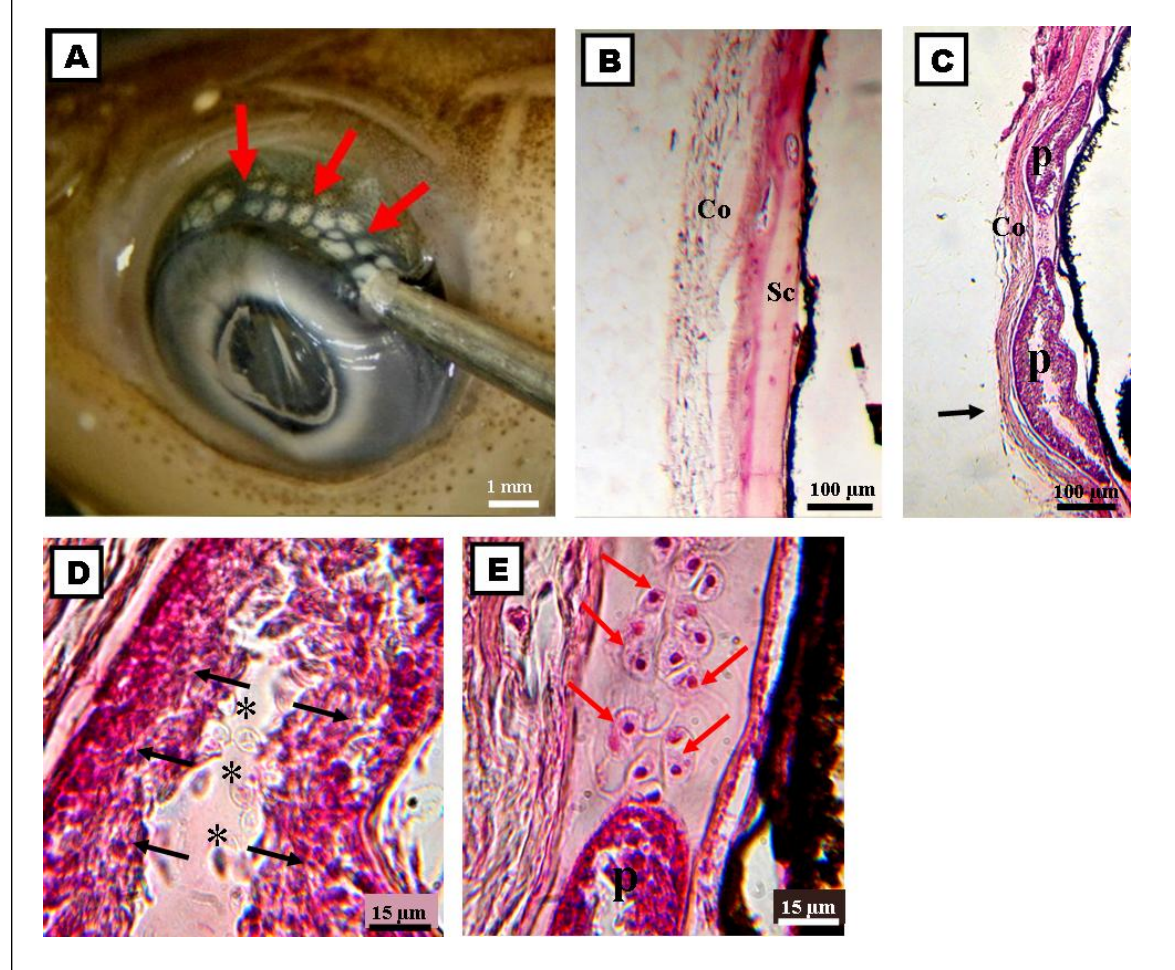
Figure 1: Microphotographs of plasmodia of Myxobolus kodjii sp. nov. in the eye of Labeo senegalensis . Clustering of plasmodia within the sclera (red arrows) (A). Histological section of the eye of L. senegalensis showing a section of a non-parasitized sclera ( B ). Histological section of a portion of infected eye showing two plasmodia within the sclera: observe the swelling of the sclera (black arrow) ( C ). Plasmodium revealing the location of mature spores (asterisks) in the medial part and immature spores (black arrows) at the periphery ( D ). Observe the influx of monocytes (red arrows) at the periphery of the plasmodium (E). (Sc = sclera, Co = conjunctiva, P =